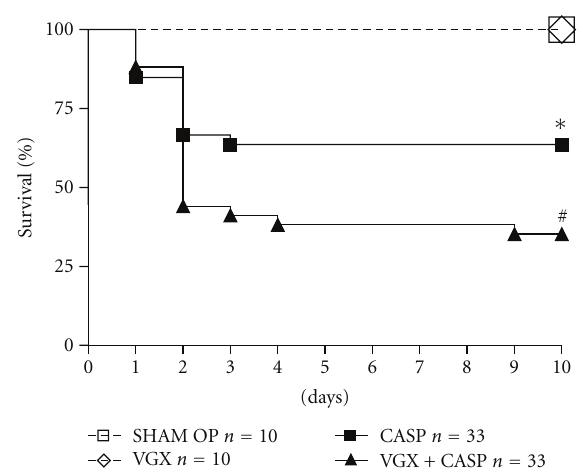
Figure 2: The mortality in polymicrobial sepsis (CASP) is signifi- cantly increased compared to sham-operation (laparotomy without CASP or vagotomy) by 63.6% versus 100% ( ∗ P = 0 . 025, n = 10 and 33, resp.). The survival of the vagotomised CASP group (VGX + CASP, n = 33) is significantly decreased further to 35.3% (CASP versus VGX+CASP: # P = 0 . 048). Vagotomy itself ( n = 10) does not a ff ect the survival rate